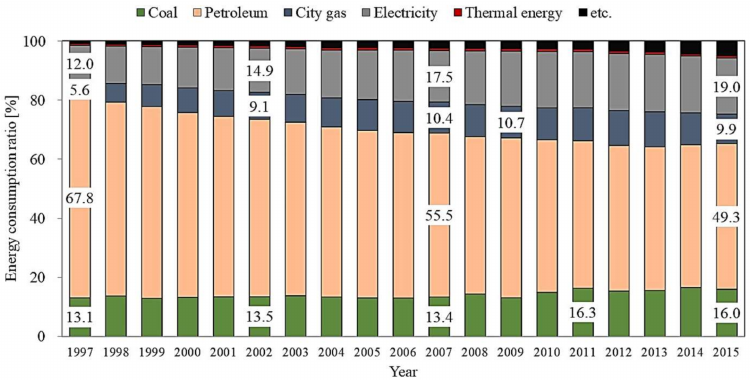
Figure 10. Percentage of energy use by energy source (%).